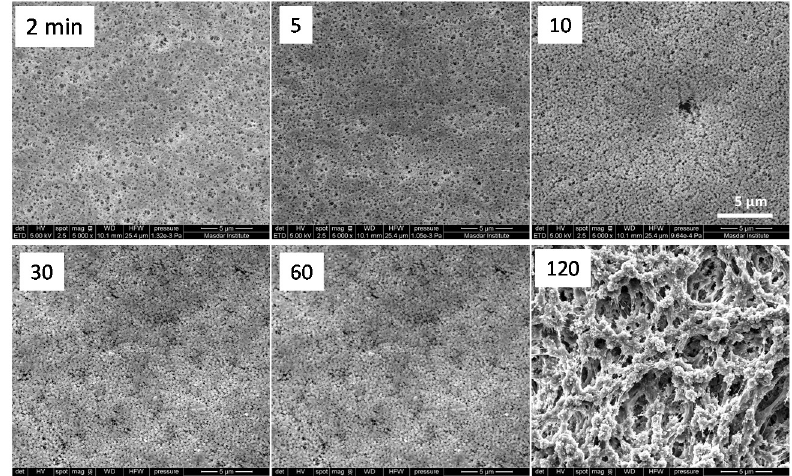
Figure 6. Surface SEM images of membrane samples prepared at different exposure times under 60% RH, 12% w / w PVDF concentration and 500 ‐μ m casting thickness. All images have the same scale bar, shown in the top ‐ right image.